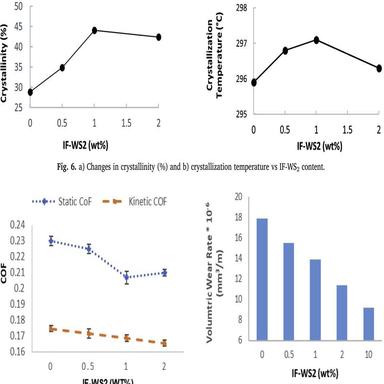
a) Static and dynamic coefficient of friction and b) wear rate for PEEK samples containing different loadings of IF-WS2.